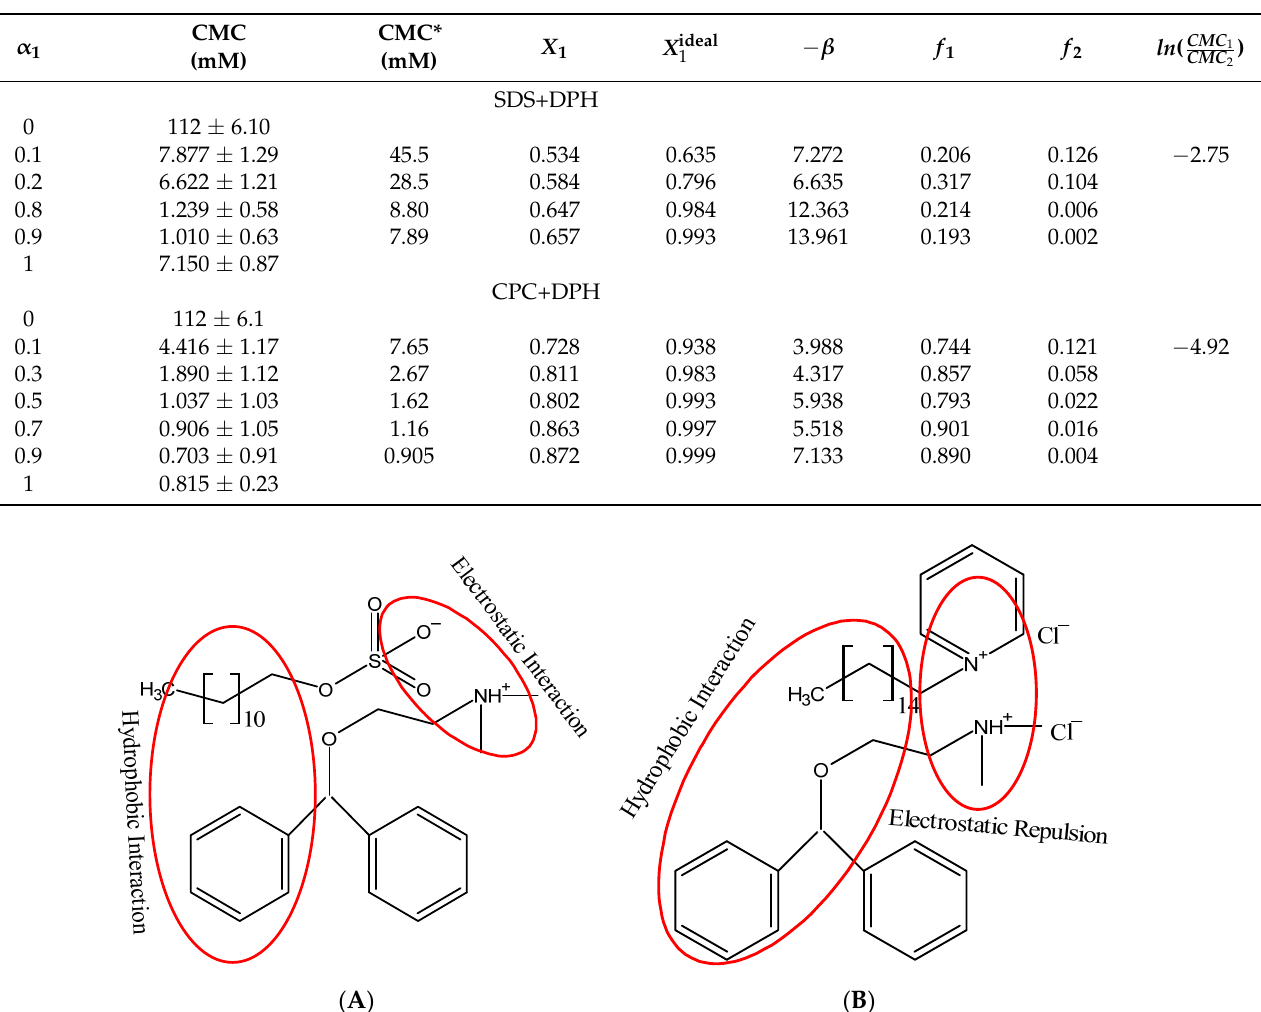
Table 1. Micellar parameters, experimental critical micelle concentration (CMC), ideal critical micelle concentration (CMC*), micellar mole fraction ( X 1 ) , ideal mole fraction ( (cid:1850) (cid:2869)(cid:2919)(cid:2914)(cid:2915)(cid:2911)(cid:2922) ), interaction parameter ( β ), activity coefficients ( f 1 , f 2 ) of DPH + SDS/CPC mixed (systems at temperature T = 298.15 K. Values are the mean ± SD ( n = 3).